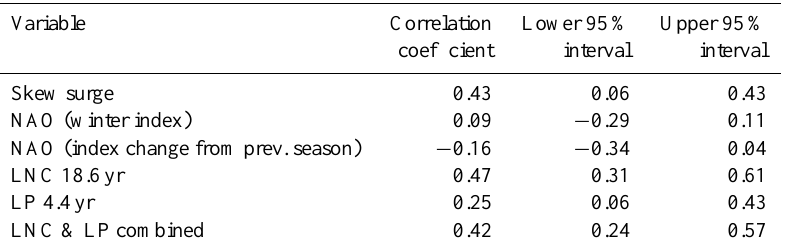
Table 5b. Correlation of the seasonal average height of high waters and various seasonal time series, with lower and upper 95% confidence